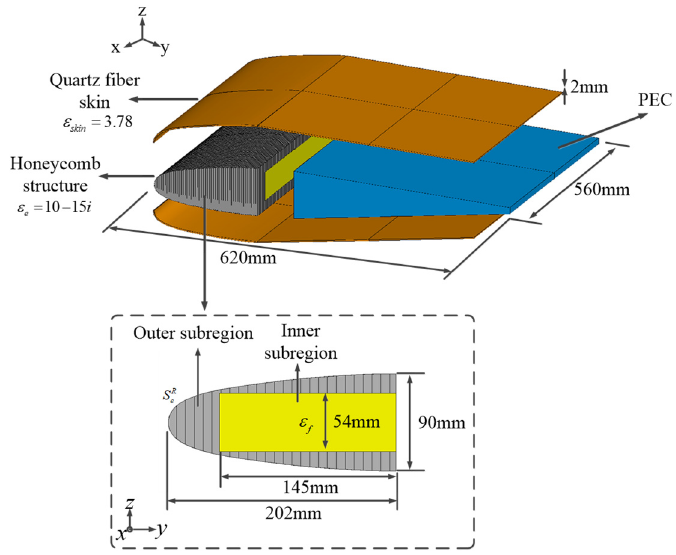
Figure 11. Geometry illustration of a wing-like model and its side view.